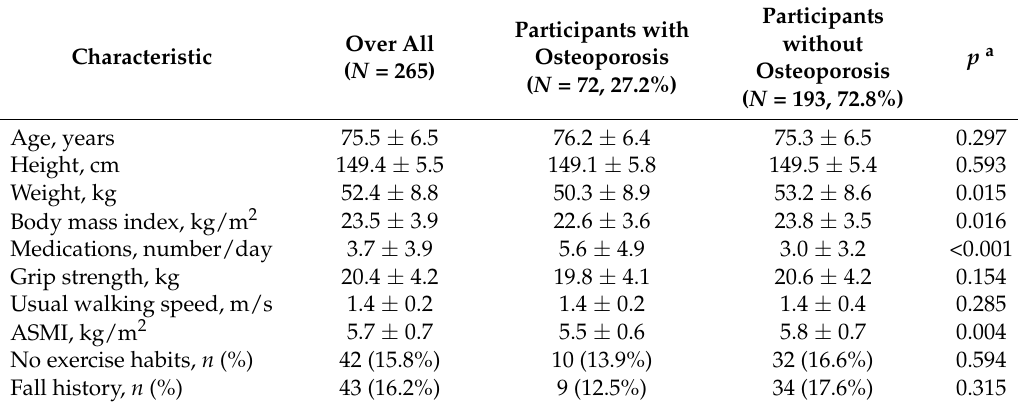
Table 1. Characteristics of the participants, mean ± SD, or